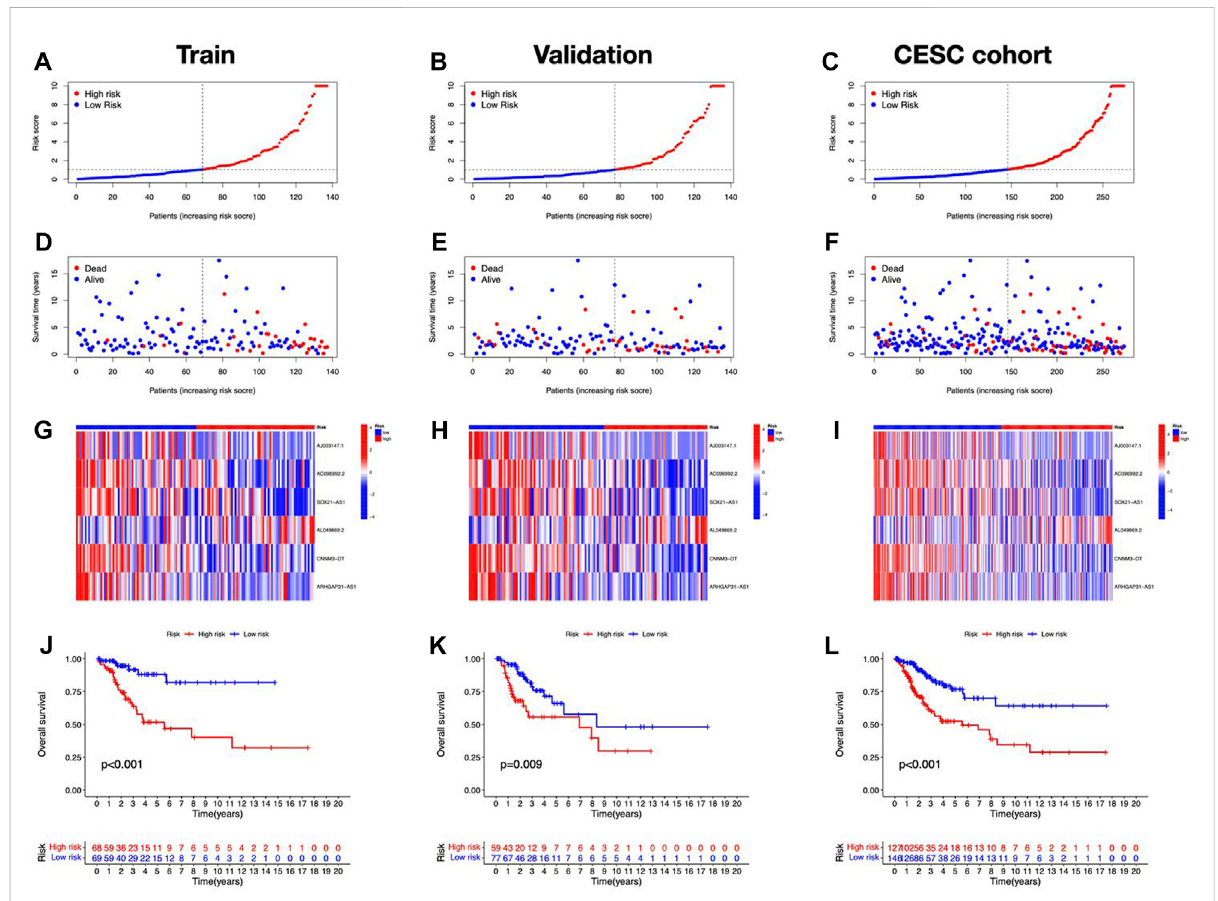
FIGURE 4 Prognosticperformance oftheriskmodelinTCGA dataset. Thedistributionofoverall survivalriskscores (A – C) ,survivalstatus (D – F) ,heatmaps of lncRNA expression (G – I) , Kaplan – Meier survival curves of OS (J – L) between risk groups in the train, validation, and entire sets,